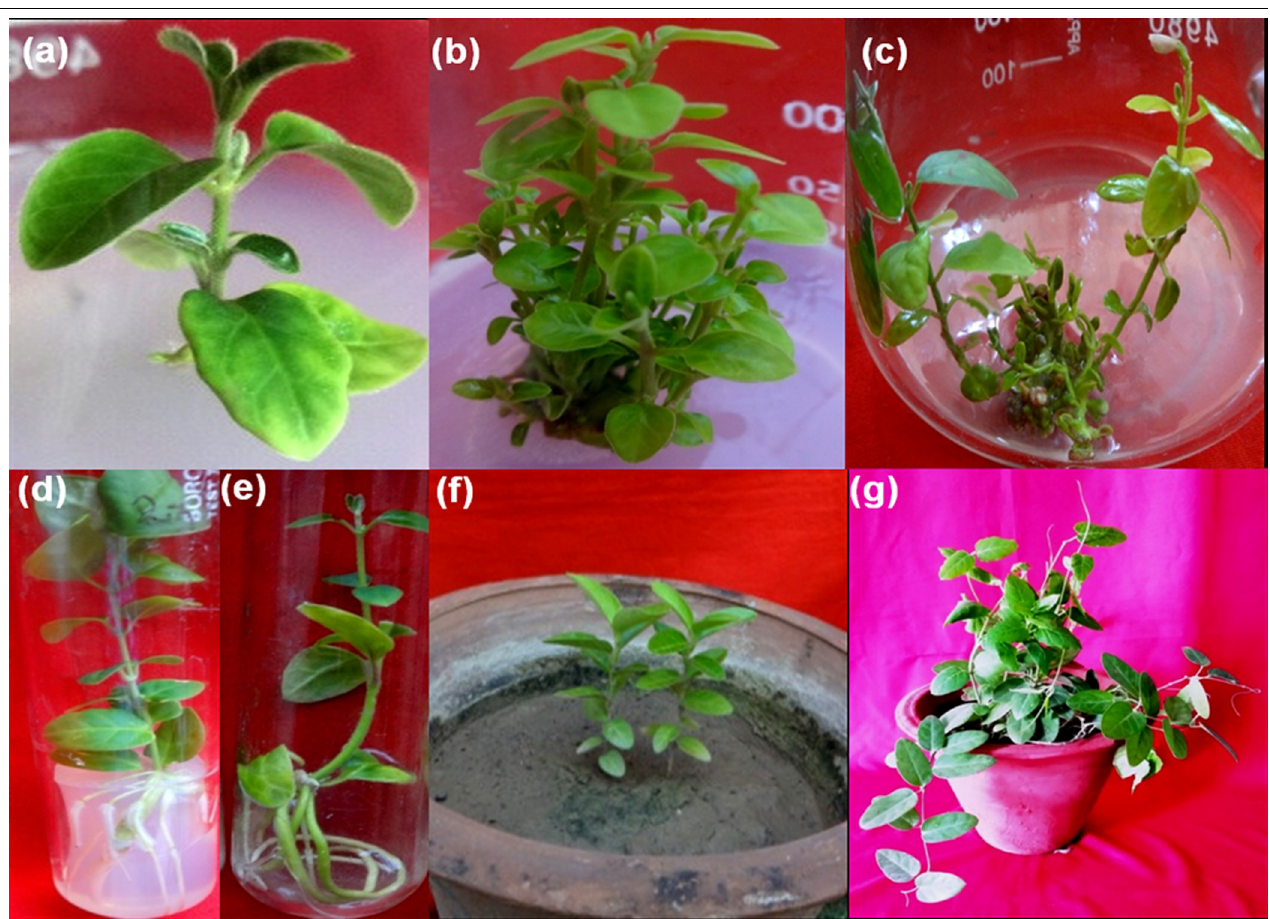
Fig 4. In vitro micropropagation of Tylophora indica . (a) Initial bud break from the nodal segment on solid MS+ BAP (15 μ M) after 10 days of culturing. (b) Numerous shoots formed on the same medium after 4 weeks. (c) Axillary shoot proliferation in liquid MS + BAP (10 μ M). (d) Rooting of regenerated shoots on solid MS + IBA (10 μ M). (e) A bunch of roots formed in liquid MS + IBA (5 μ M). (f) Hardened plantlets in green house. (g) A 4-months-old well acclimatized plant in the field conditions.